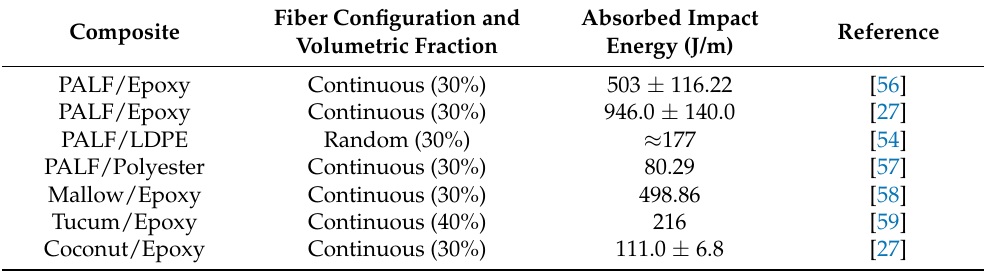
Table 3. Izod impact test results from the literature.